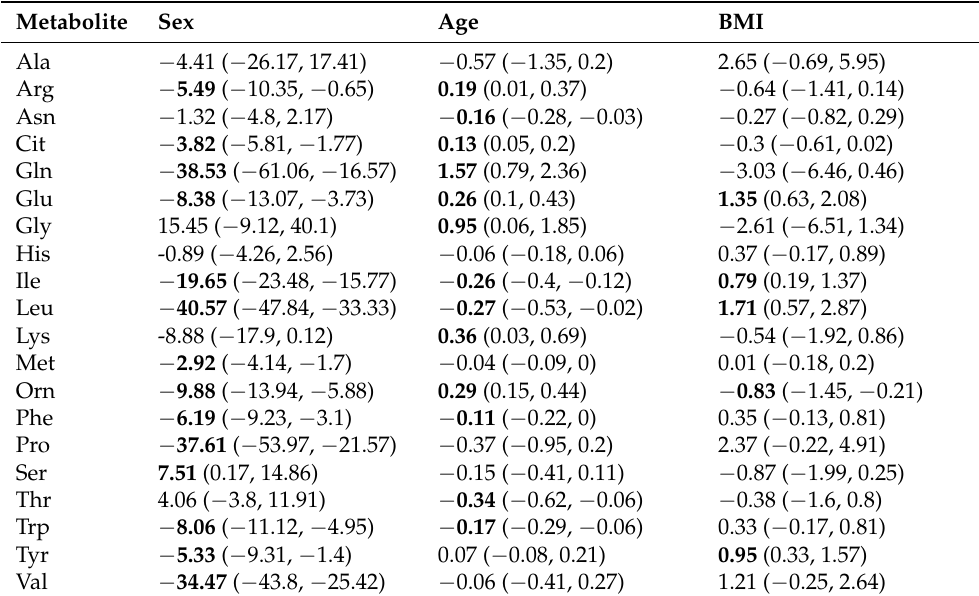
Table 1. Estimates of all regression coefficients for each metabolite, with 95% credible intervals in parentheses.